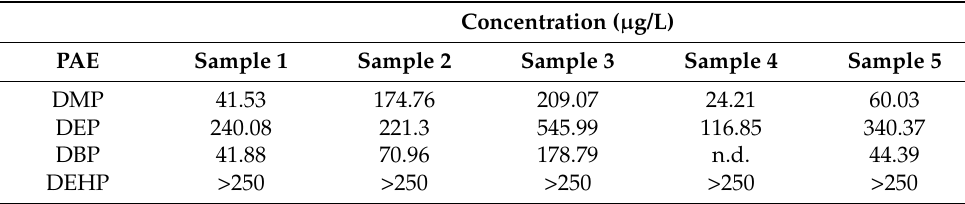
Table 3. PAE concentrations in leachate samples from a MSW